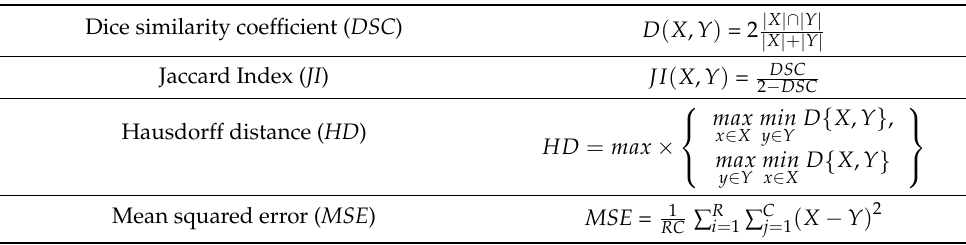
Table 2. The formulation of evaluation